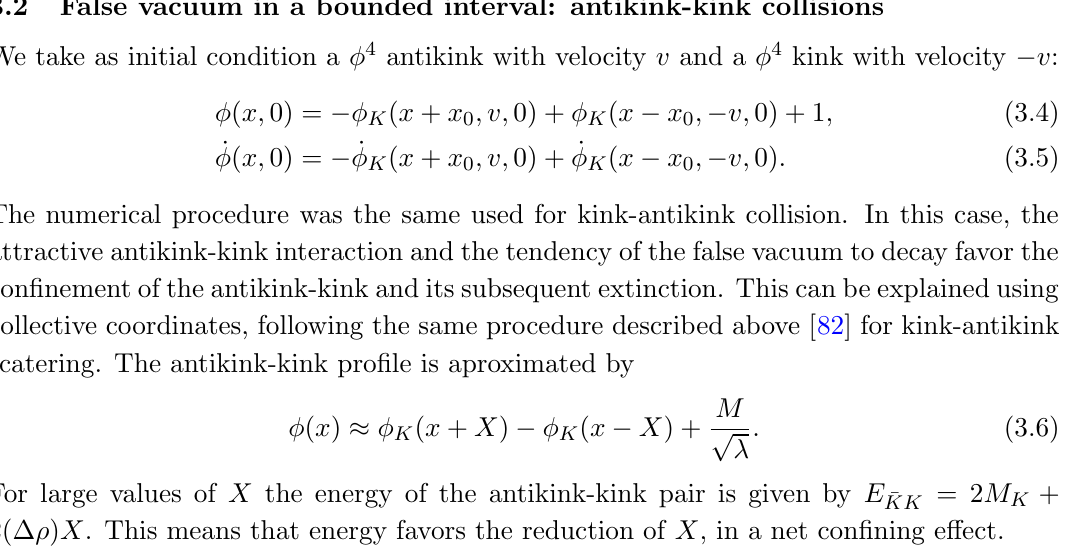
p = 2 M (cid:0) 2((cid:1) (cid:26) ) X; where M = 2 2 M 3 = (3 (cid:21) ) K K K (cid:22) K